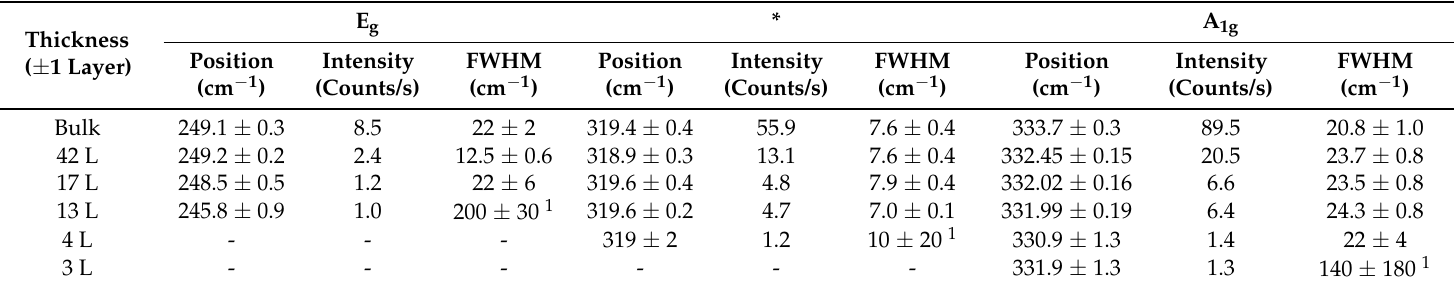
Table C1. Thickness dependence of the fitted parameters (position, intensity, and FWHM) of the E g and A 1g modes obtained from the Raman spectra for ZrS 2 on a Si/SiO 2 substrate ( λ = 532 nm) presented in Figure C2.